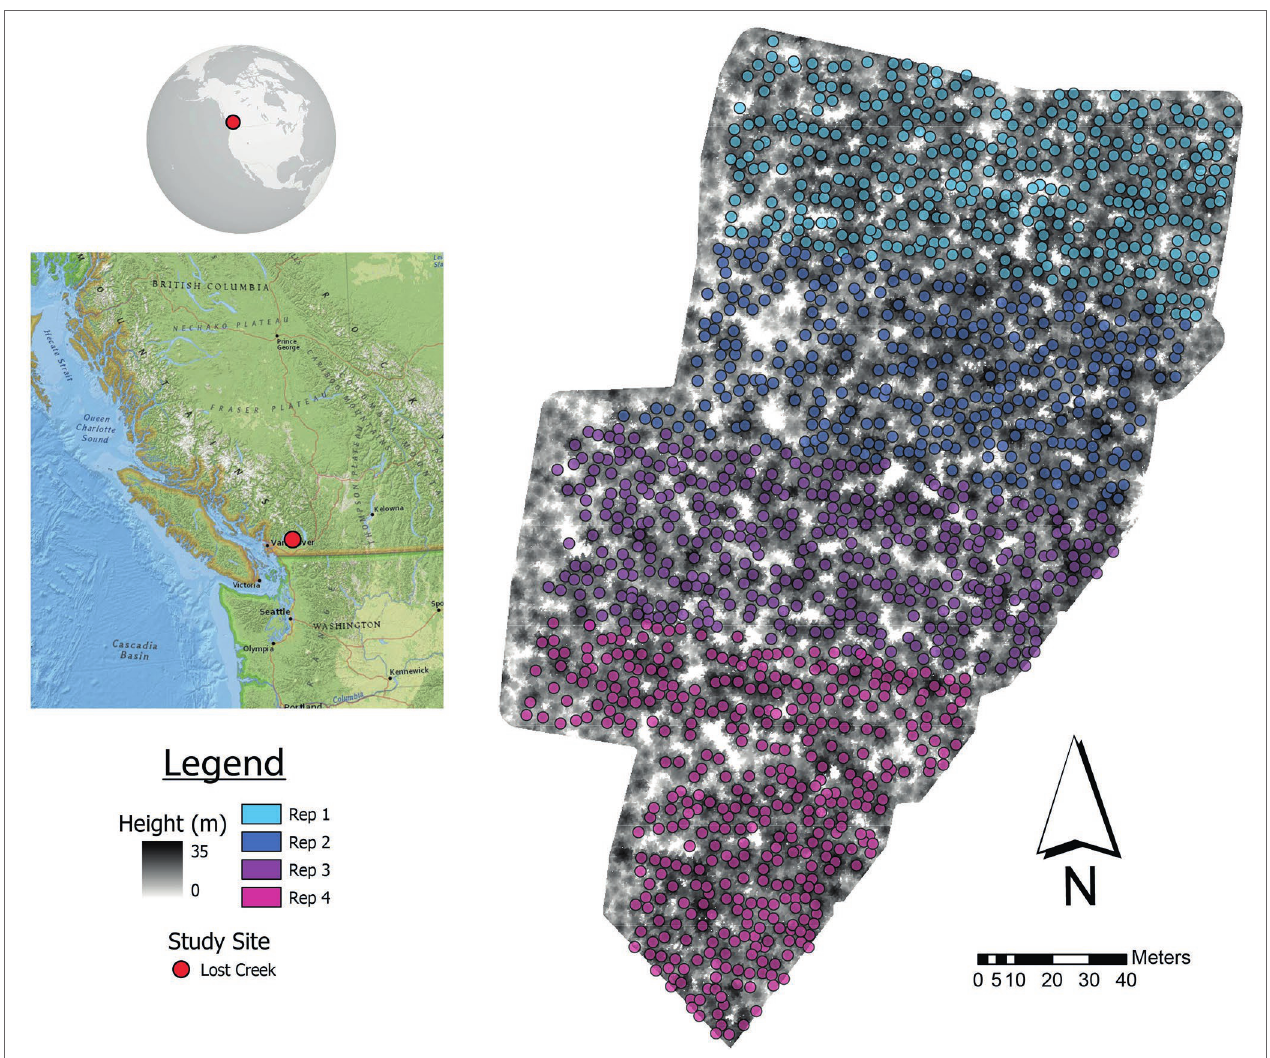
FIGURE 1 | Lost Creek progeny trial showing ALS-detected trees matched with ground locations by repetition (Rep). A canopy height model (CHM) shows the configuration of trees within the trial. The location of the study area in BC, Canada is shown on the